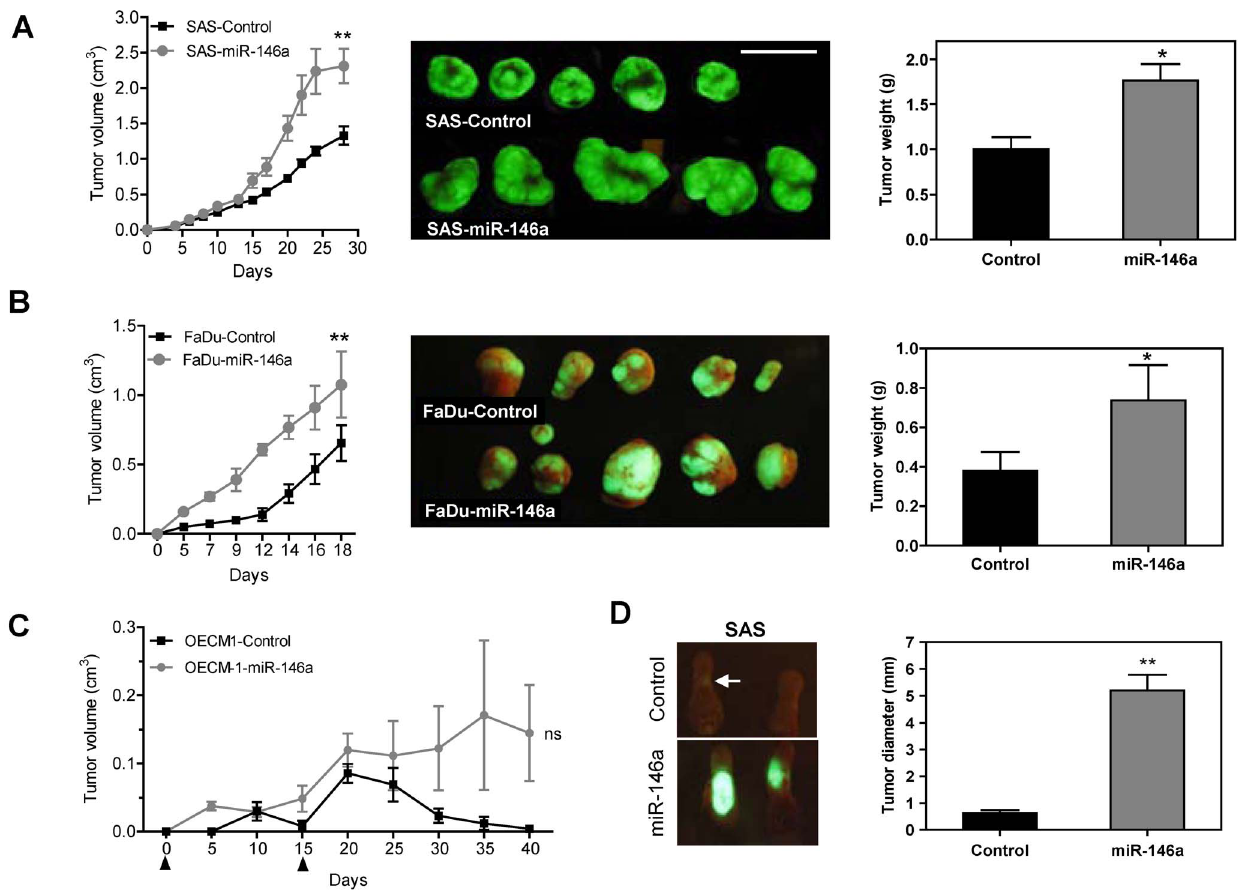
Figure 3. Exogenous miR-146a expression enhances the tumorigenesis of OSCC. (A–C) Subcutaneous tumorigenesis of SAS, FaDu and OECM-1 cells, respectively, in an athymic mouse model. (A, B) Lt, the growth curves of the xenografts. Middle, fluorescent photographs of the resected tumors after sacrifice. Rt, quantification of the tumor weight. (C) The growth curve of the OECM-1 xenografts. Arrowheads indicate the time points for tumor cell inoculation. (D) Orthotopic tongue tumorigenesis of SAS cell subclones. Lt, fluorescent tumors caused by the SAS cell subclones with exogenous miR-146a expression are present in the tongue of the test animals, but not in the control animals. An arrow indicates the barely visible fluorescent mass in a control mouse. Rt, quantification of the tumor size. Data shown are the means 6 SE from at least six mice. ns , not significant; *, p , 0.05; **, p , 0.01; Mann-Whitney test or Two-Way ANOVA test.